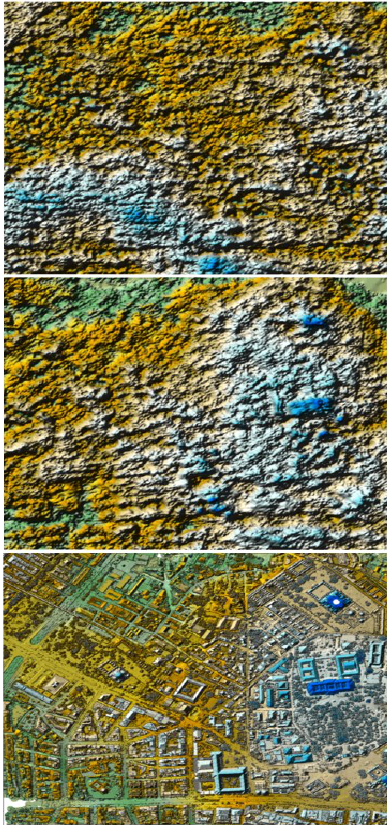
Figure 3. Generated 3D DSMs without exaggeration (CSK DSM= upper; TSX DSM= middle; reference DSM= lower) The 3D earth modelling potential of the CSK and TSX DSMs was analyzed calculating absolute vertical accuracies (AVA) and relative vertical accuracies (RVA) on varied land forms showed in Figure 4 with land cover percentages. For validation of tested DSMs, software BLUH version 2012 (bundle block adjustment Leibniz University Hannover) (Jacobsen 2011) was utilized.